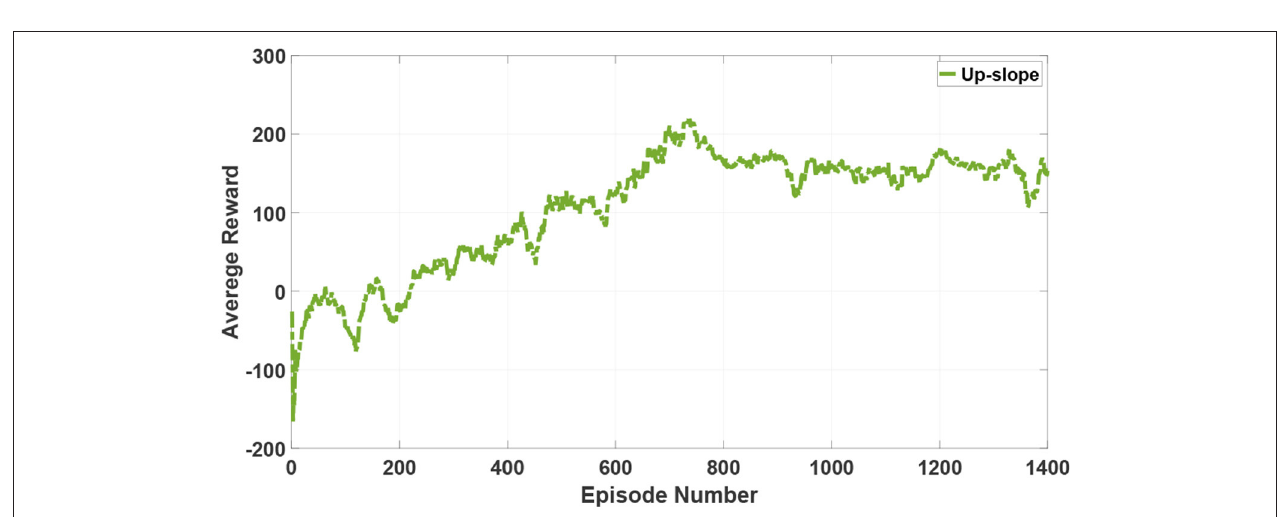
FIGURE 11 | The average reward of reinforcement learning in the quadruped